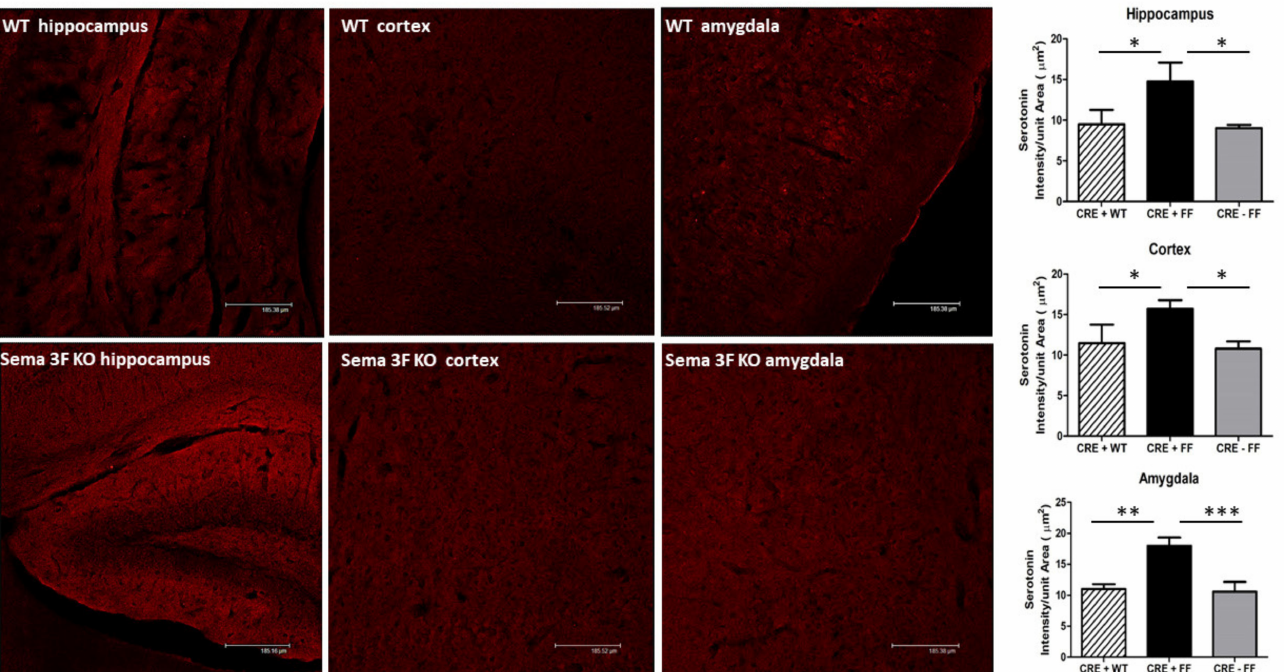
Figure 10. Elevated Serotonin Expression in Sema 3F KO Mice . Left panel: Serotonin immunoflu- orescence in hippocampus, cortex, and amygdala of Sema 3F KO mice and their wild type (WT) littermate showed significantly increased serotonin expression in Sema 3F KO tissue. Right panel: quantification of serotonin immunofluorescence showed significantly higher fluorescence/unit area in the hippocampus, cortex, and amygdala of Sema 3F KO mice compared to the two control mice. *** p ≤ 0.0001; ** p ≤ 0.001; * p ≤ 0.01; n =